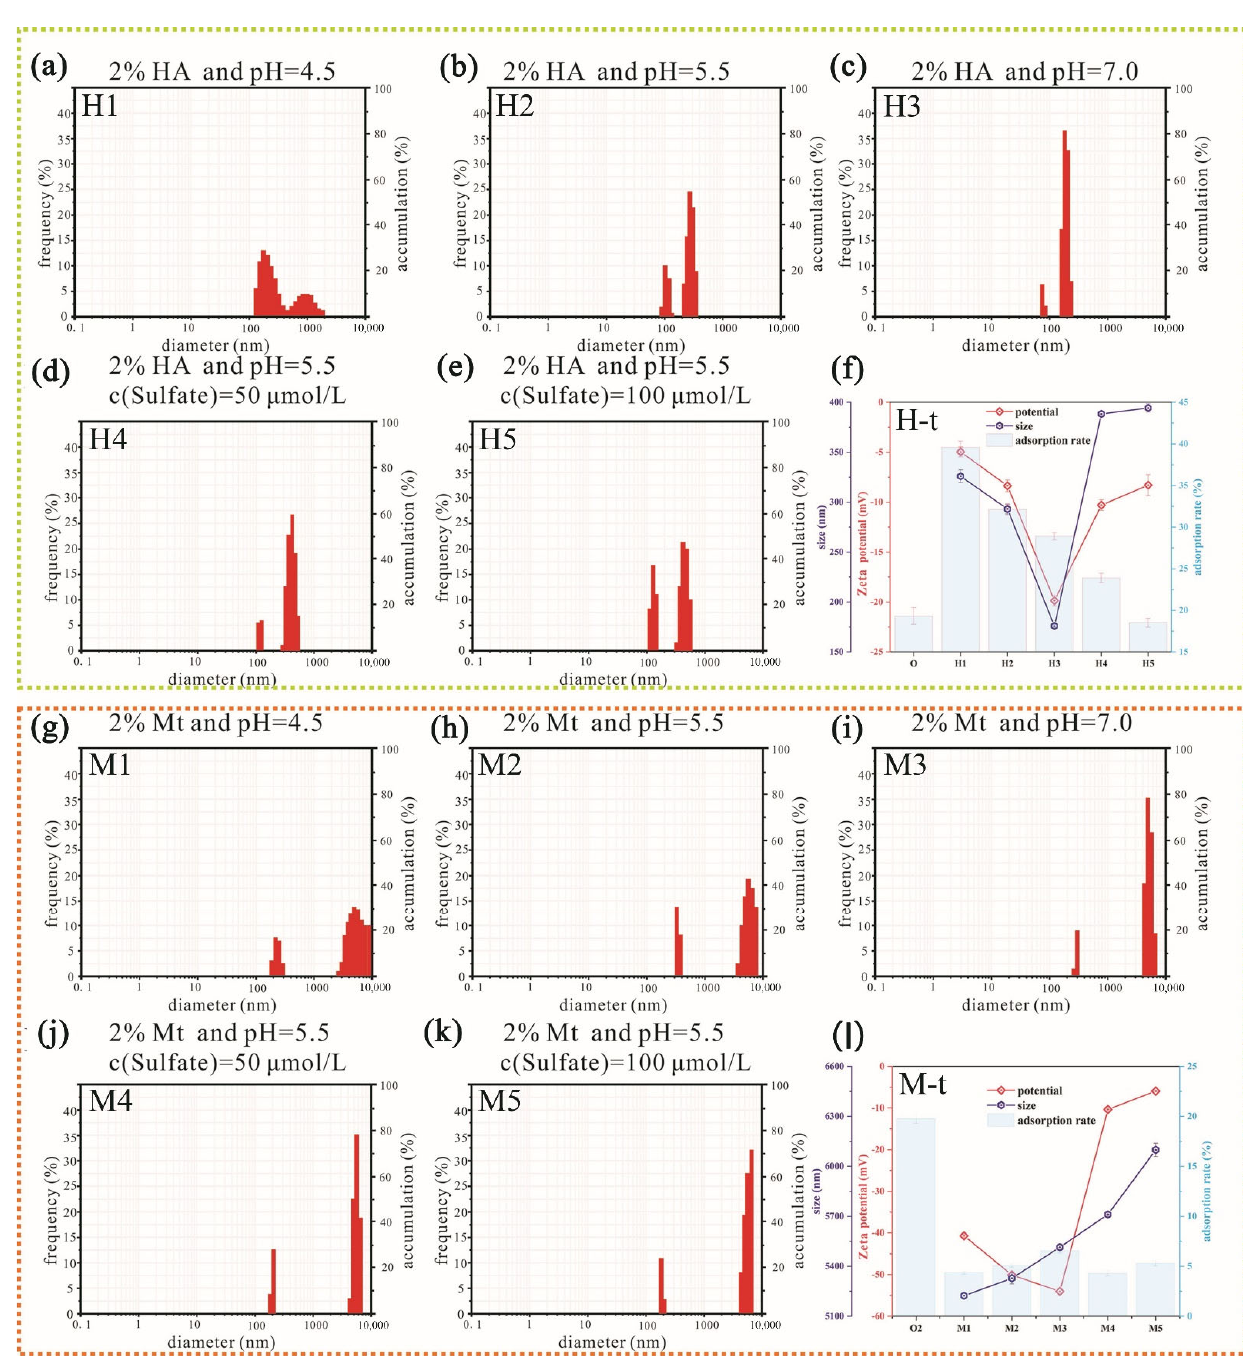
Figure 2. The particle size and zeta potential distribution of the colloid and the adsorption of Cr (VI) by the medium under different conditions. ( a – c ) H1–H3 represent the particle size distribution of the HA–Cr system at different pH. ( d , e ) H4–H5 represents the particle size distribution of the HA–Cr system at different sulfate concentrations. The O group in (( f ), H ‐ t) represents the cinnamon soil without colloid; ( g – i ) M1–M3 represent the particle size distribution of the Mt–Cr system at different pH. ( j , k ) M4–M5 represents the particle size distribution of the Mt–Cr system at different sulfate concentrations. The O2 group in (( l ) M ‐ t) represents the silt soil without colloid, and the other groups correspond to those in the figure (“2%” is colloidal mass 2% of the total soil mass).